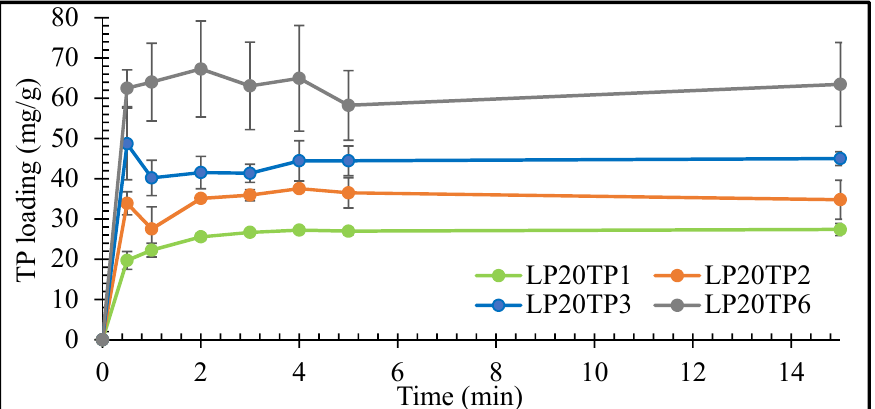
Figure 5. Uptake kinetics of TP by LP with 20 mg/mL LP. Values expressed are means with standard deviations as error bars, n = 3.